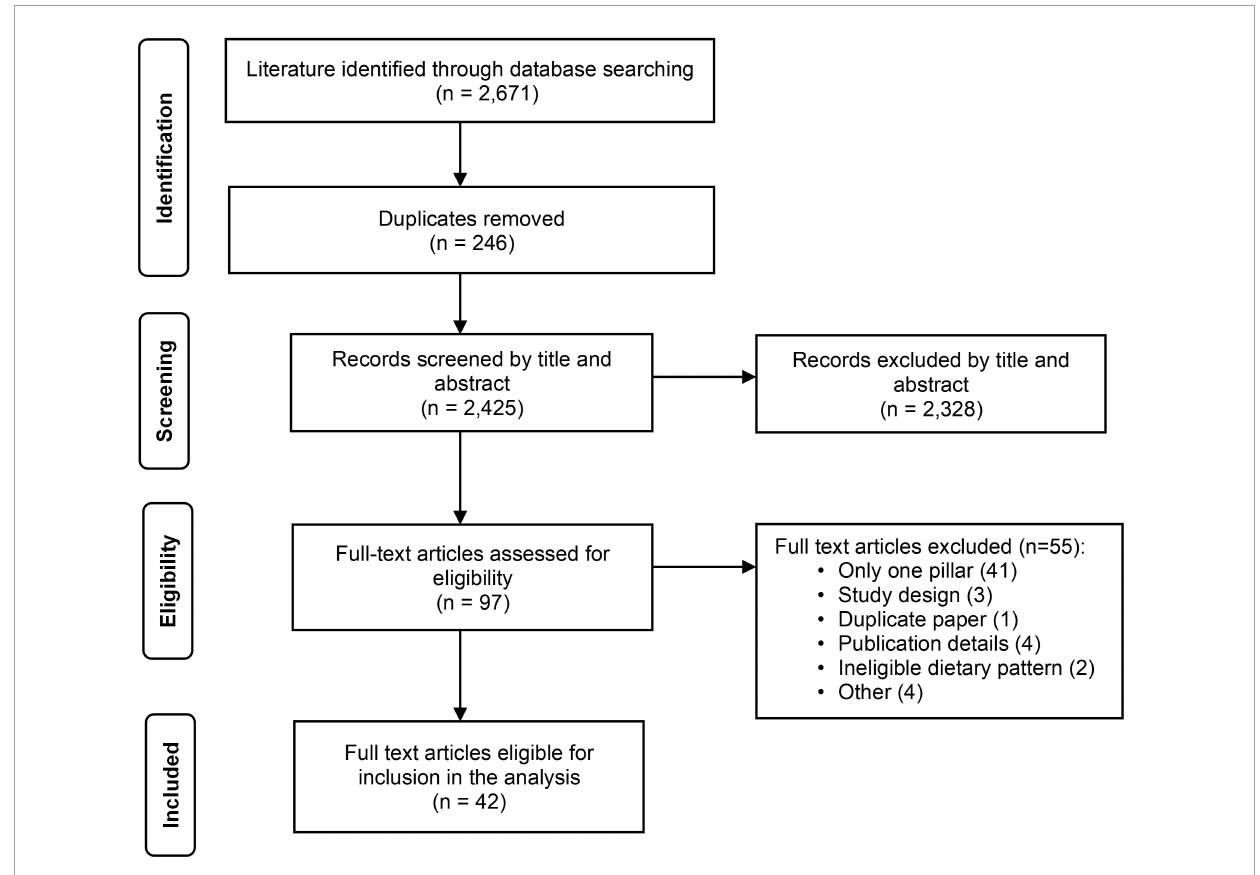
FIGURE1 PRISMA flow diagram.